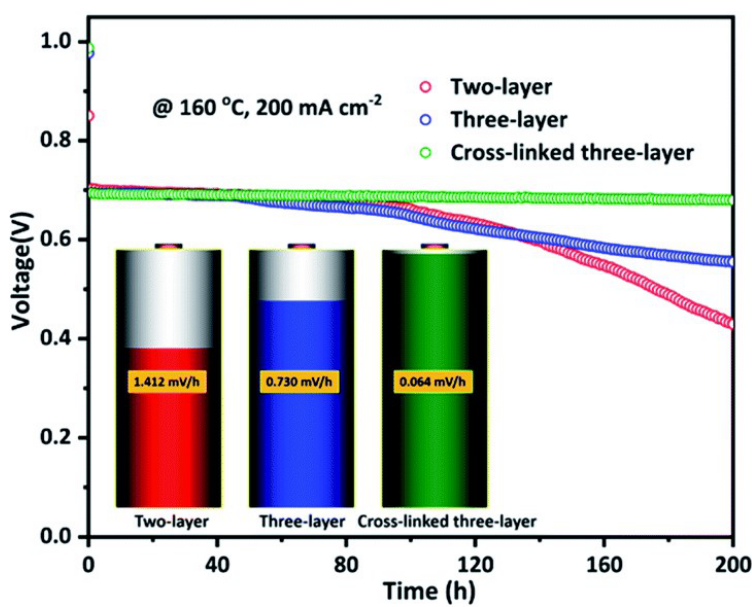
Figure 6. The voltage of different PBI-based membranes (taken from Ref. [70]).